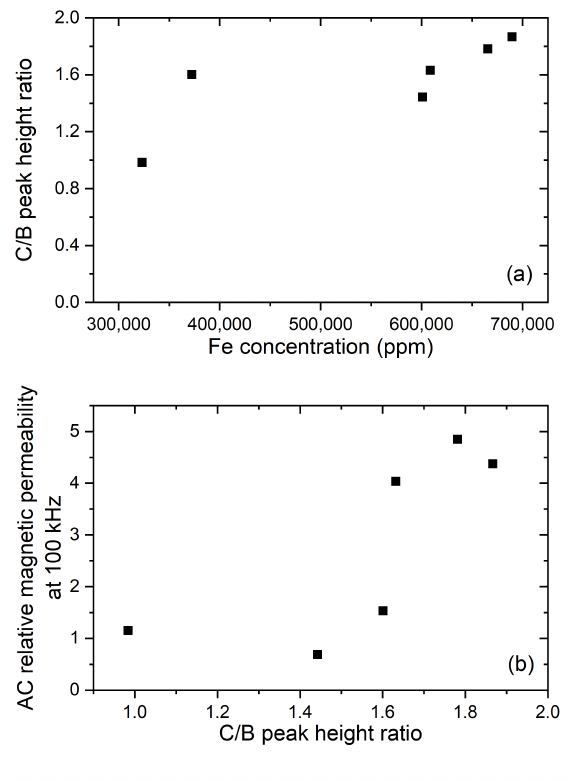
Figure 4. Comparison of the changes of the C/B ratio in the measured Fe L-edges against ( a ) measured Fe concentration and ( b ) magnetic